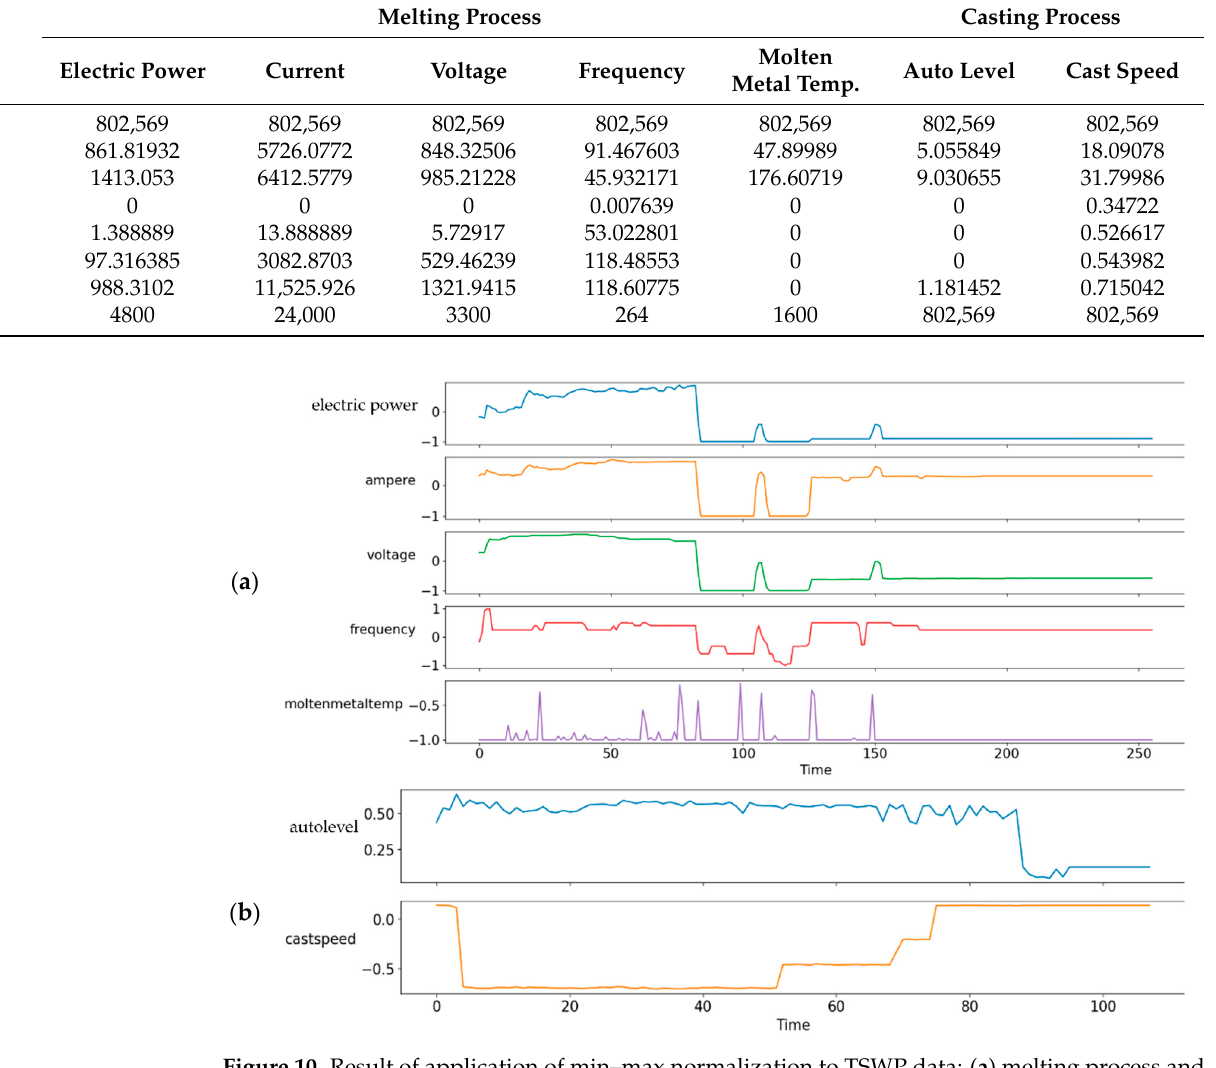
Figure 10. Result of application of min–max normalization to TSWP data: ( a ) melting process and ( b ) casting process.